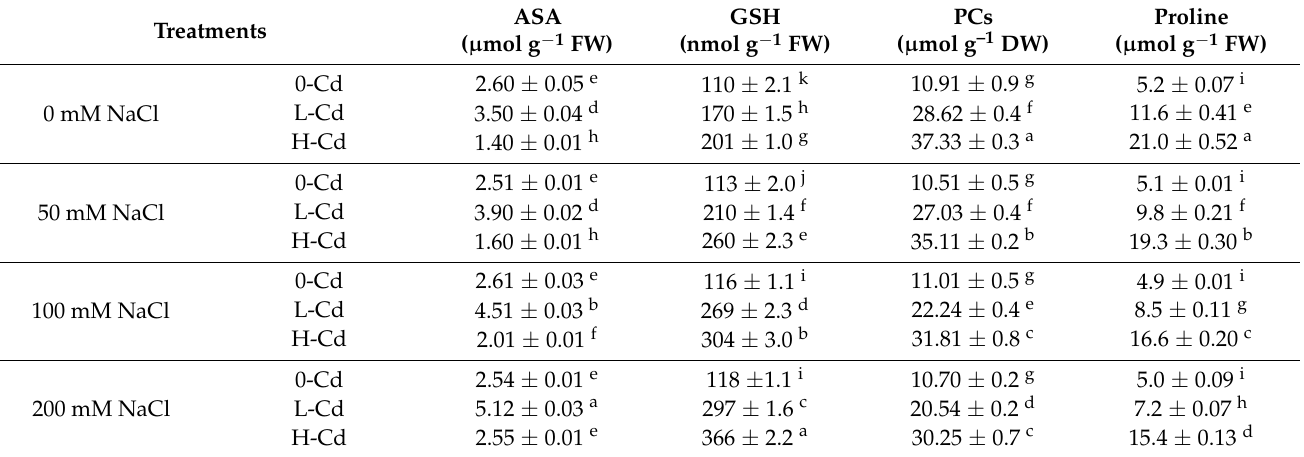
Table 3. Concentrations of ascorbic acid (ASA; µ mol g − 1 FW), reduced glutathione (GSH; nmol g − 1 FW), phytochelatins (PCs; µ mol g − 1 DW), and proline ( µ mol g − 1 FW) in leaves of Salicornia fruticosa exposed to nutrient solution containing 0, 25, and 50 µ g L − 1 Cd (0-Cd, L.-Cd, and H.-Cd, respectively) without or with NaCl 50, 100, and 200 mM. Each value is the average of four replicates ± SE.